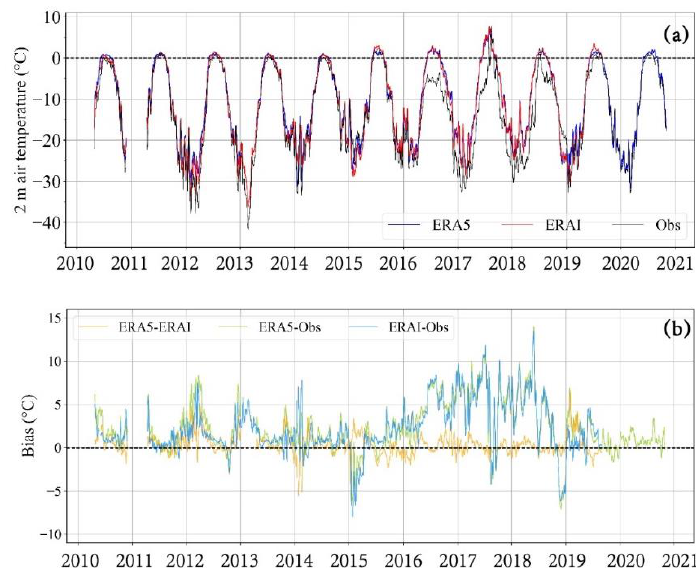
Figure 2. The time series of ( a ) the daily mean Ta values from the ERA5, ERA-I, and buoy observations and ( b ) the biases between the ERA5, ERA-I, and buoy observations averaged from all of the buoys’ trajectories during 2010–2020. To obtain a better interpretation of the results, 7-day smoothing was applied to the time series shown here.